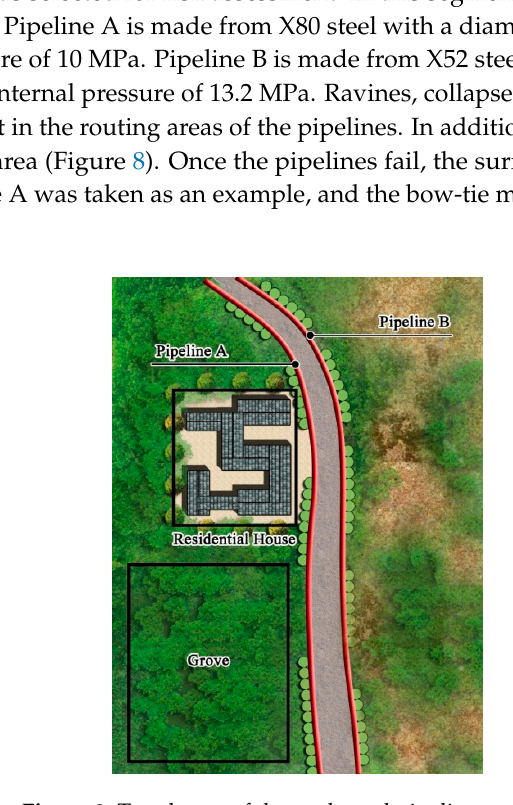
Figure 7. Assessment process of the PLOD system.